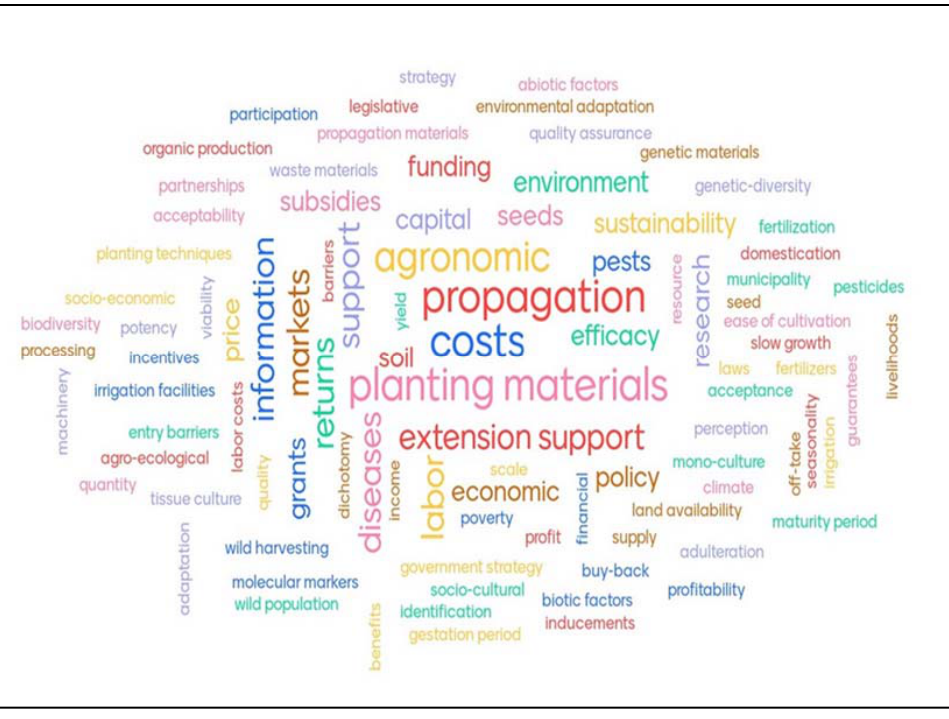
Figure 1. Word cloud showing the various constraints identified by authors from the literature search.